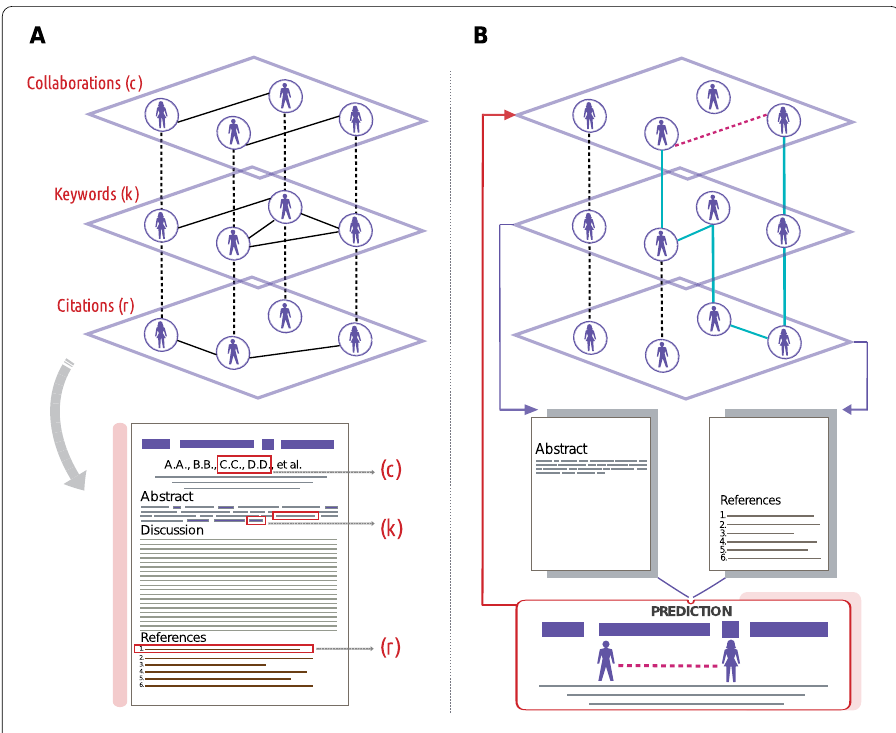
Figure 1 Predictionofnewcollaborationsusingmultiplexnetworks . We first build a multiplex network using three different kinds of relational data between scientists (panel A ) and then use two of them (panel B ) to predict new collaborations among them. See the text for further details